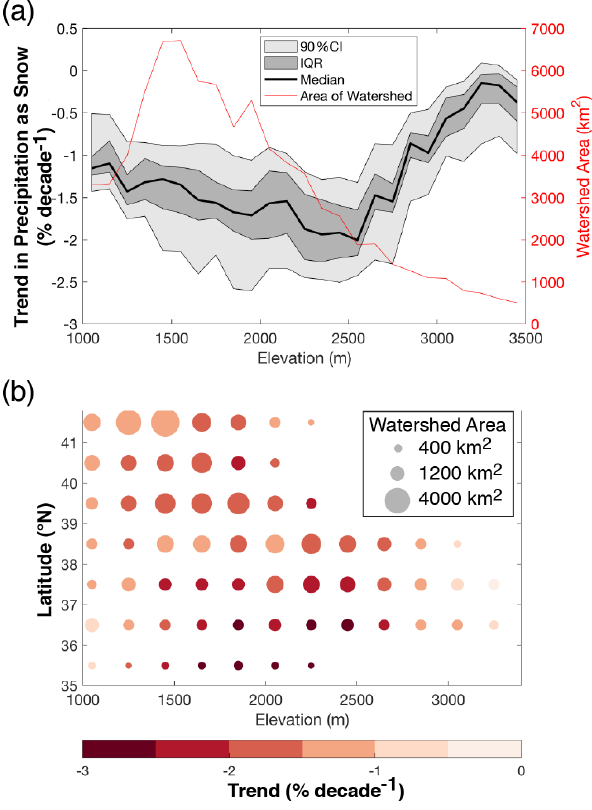
Figure 5. (a) Elevation-based trends (aggregated over all latitudes) of % SNOW (% per decade) showing median (black line), the in- terquartile range (dark gray shading), and 90% confidence intervals (light gray shading) on the left y axis. Right y axis shows the to- tal watershed area occupied by each elevation bin (red line; km 2 ). (b) Aggregated trends in % SNOW (% per decade) by latitude and elevation for the water year. Dot size is scaled by area of water- shed occupying each elevation and latitude bin. Aggregations were performed on grid points within the subset of California Depart- ment of Water Resources analysis zones (see Fig. 1a) and sorted by elevation. The interquartile range (IQR) and 90% confidence inter- val (CI) were estimated using all grid points within each elevation band and analysis